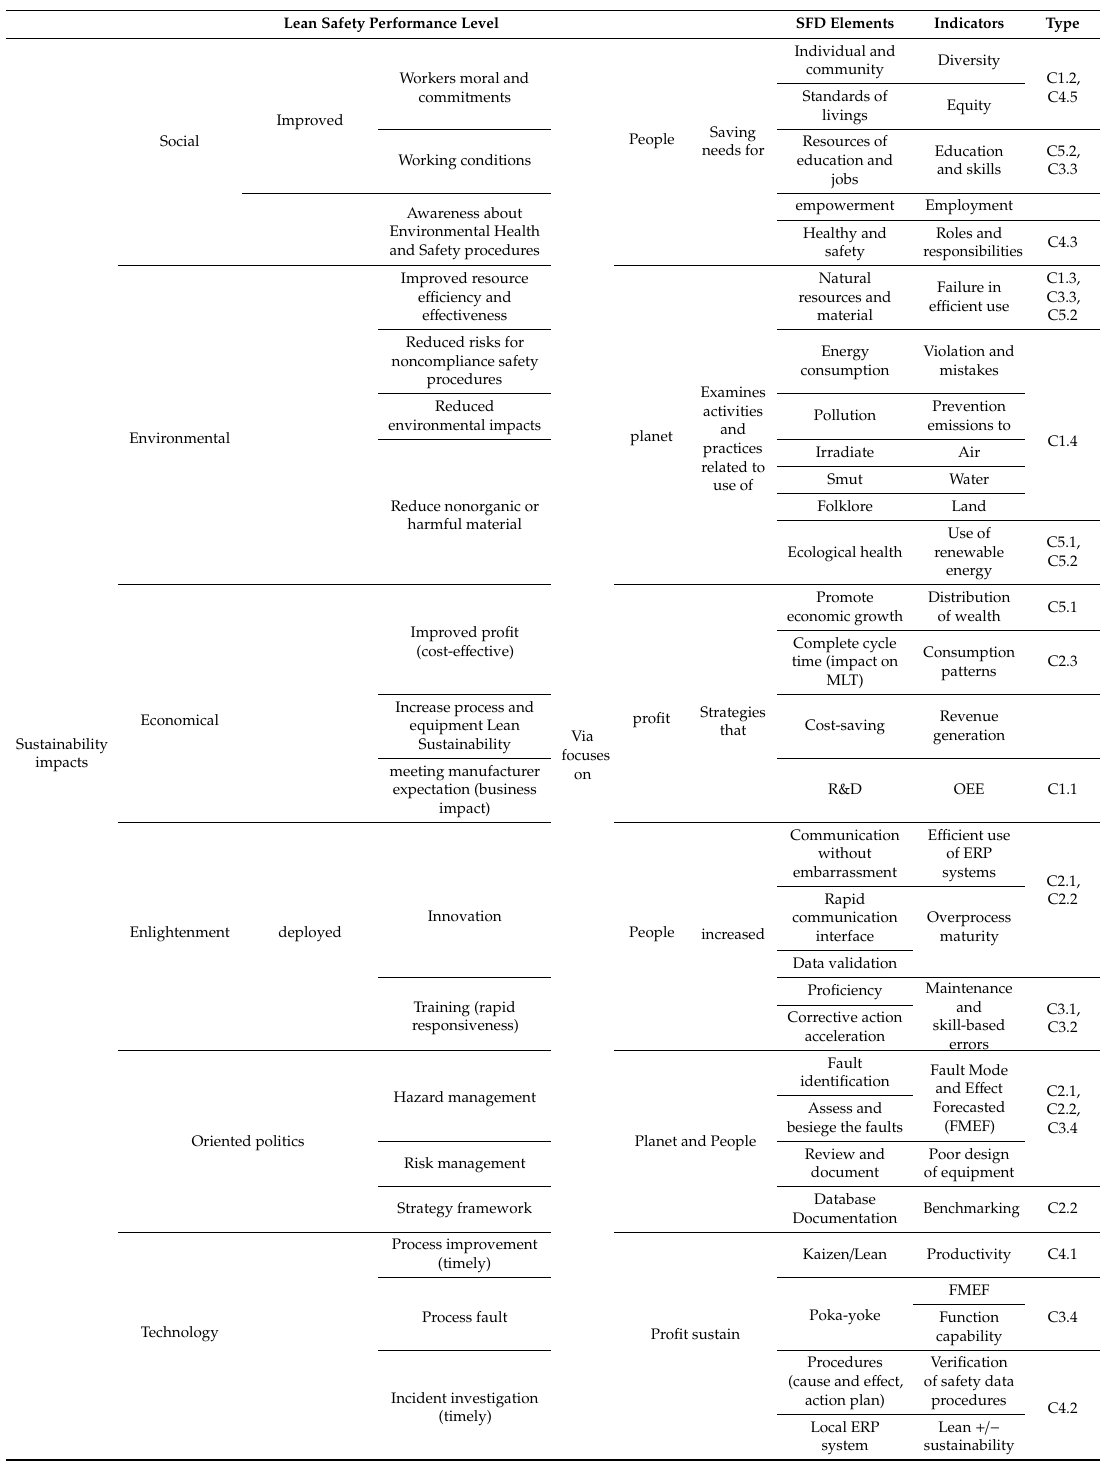
Table 2. Lean Safety Performance Level (LSPL) and Safety Function Deployment